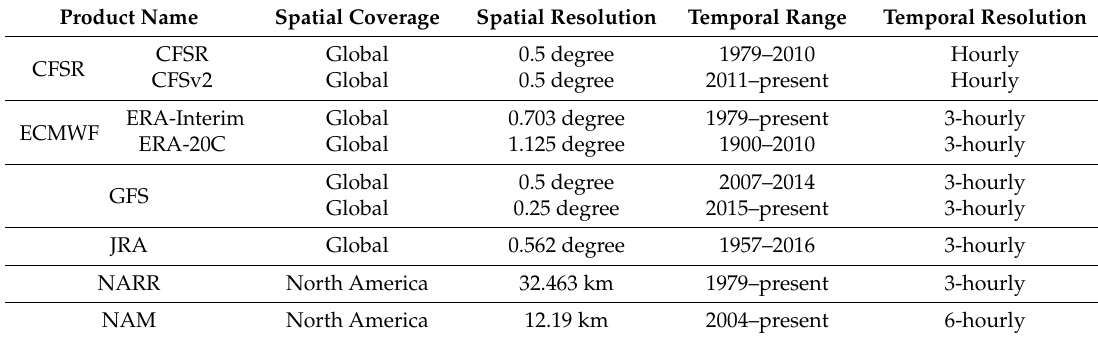
Table 1. Evaluated wind-model